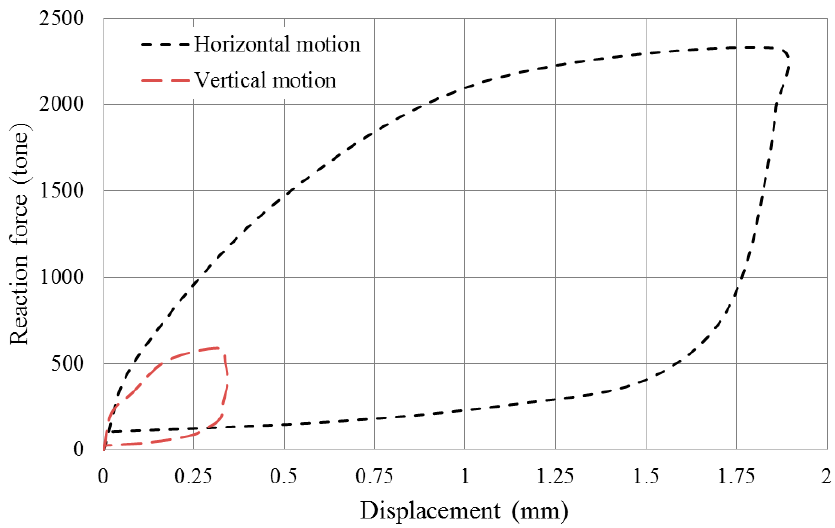
Figure 12. Hysteresis curve as a result of an impact wave due to an MCL earthquake.